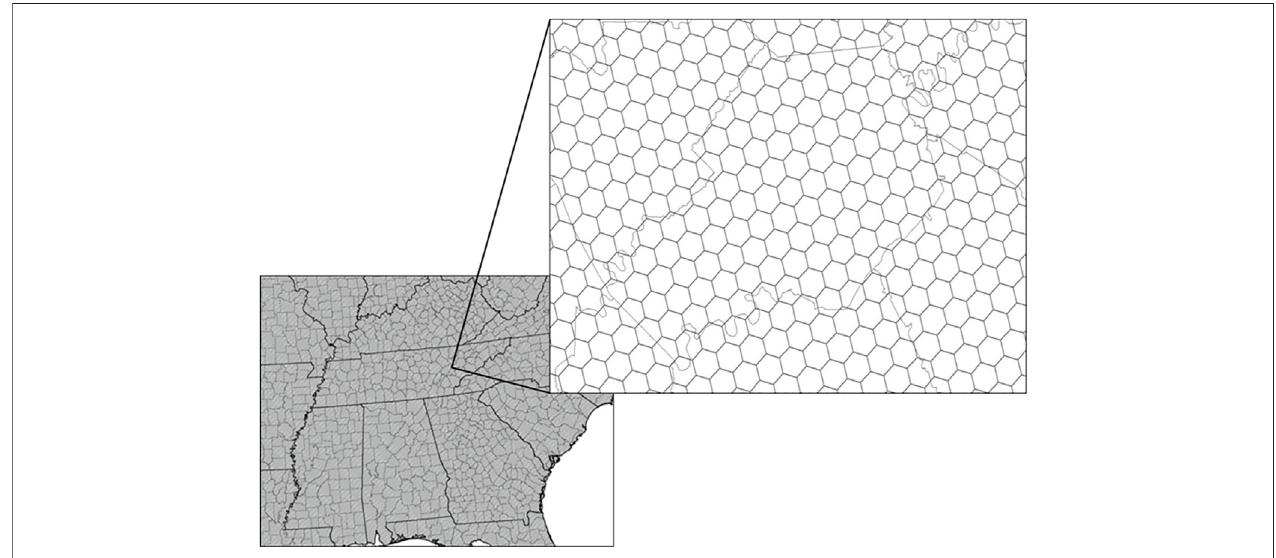
FIGURE 3 | BioFLAME ’ s supply regions.